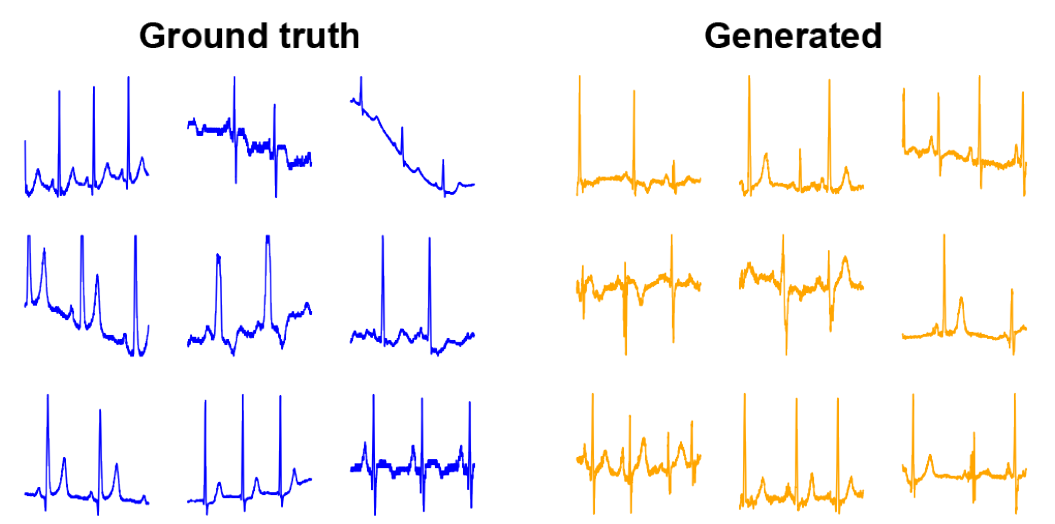
Figure 8. Ground truth Cardiogram signals vs. generated time series from samples through 200 epoch training with a CNN